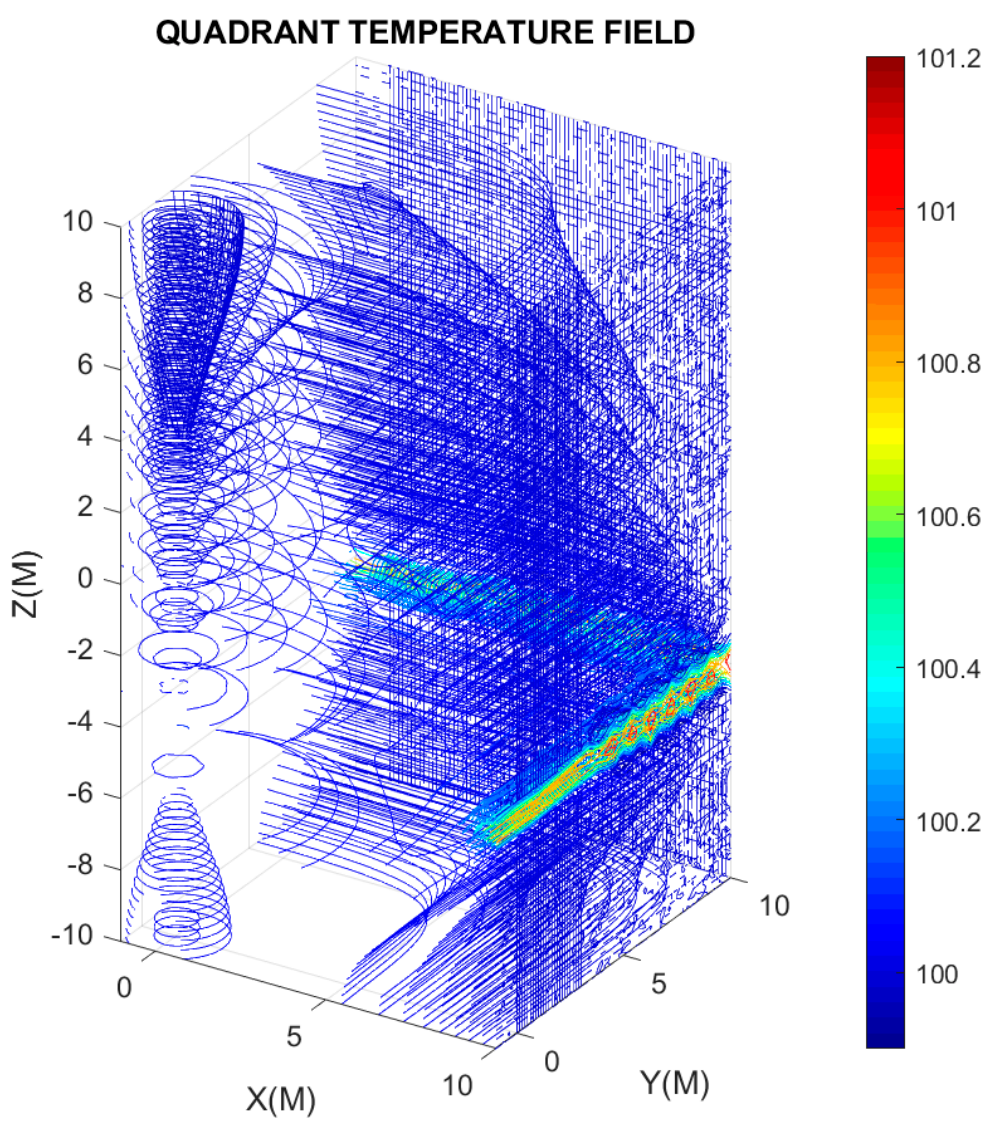
Figure 8. Quarter section of temperature distribution over wellbore-centric computational volume for thin fracture-connectivity plane illustrated in Figure 7. Wellbore axis is located at (x,y) = (0,0). Model dimensions in meters. Model temperatures are nominal 100 °C with 1 °C of elevated temperature at z = 4 horizon of advective flow entry from enclosing crustal volume.